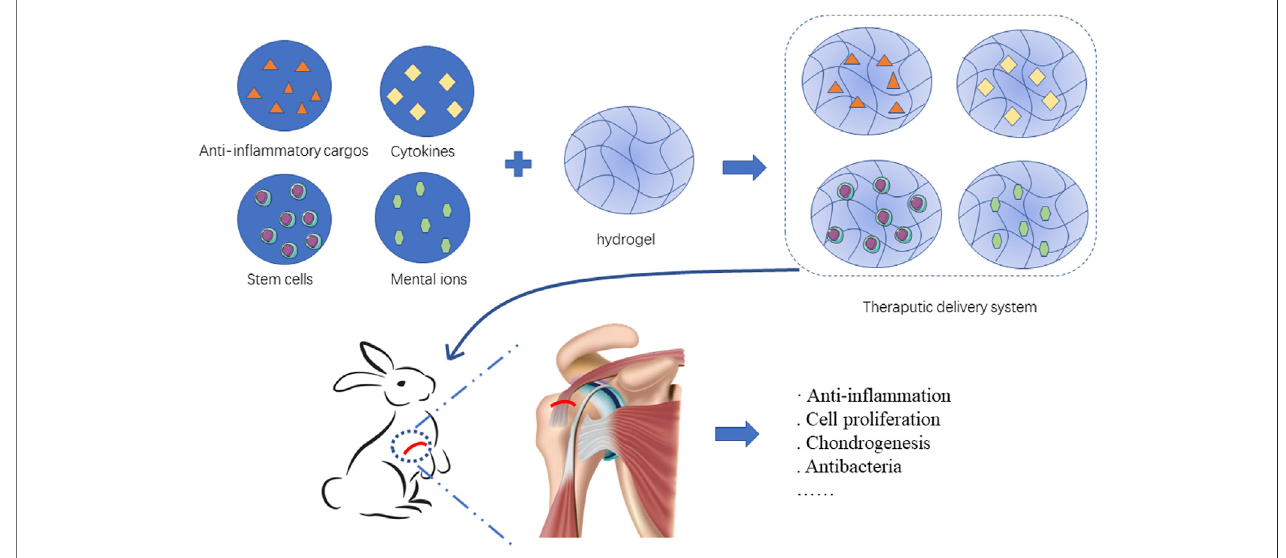
FIGURE 2 | Hydrogels load therapeutic cargos such as Anti-in fl ammatory cargos, cytokines, stem cells and mental ions to facilitate rotator cuff healing.